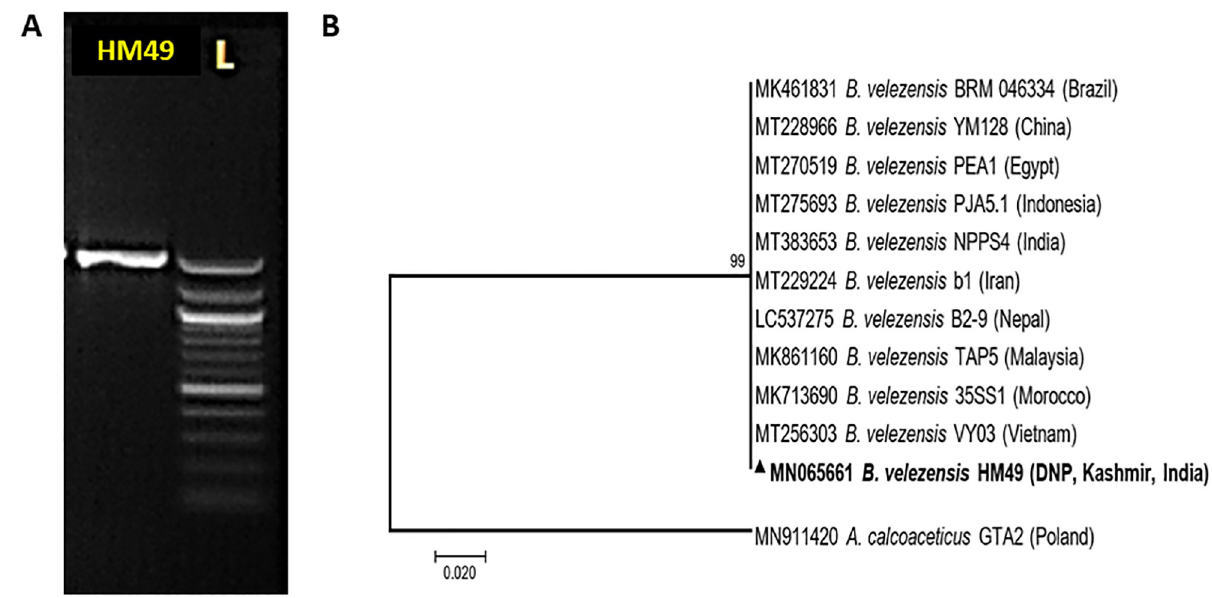
Fig 3. 16S rRNA gene-based molecular identification of Bacillus velezensis HM49. Representative electrophoretic image of amplified PCR product (A); evolutionary neighbor-joining phylogenetic tree (B).